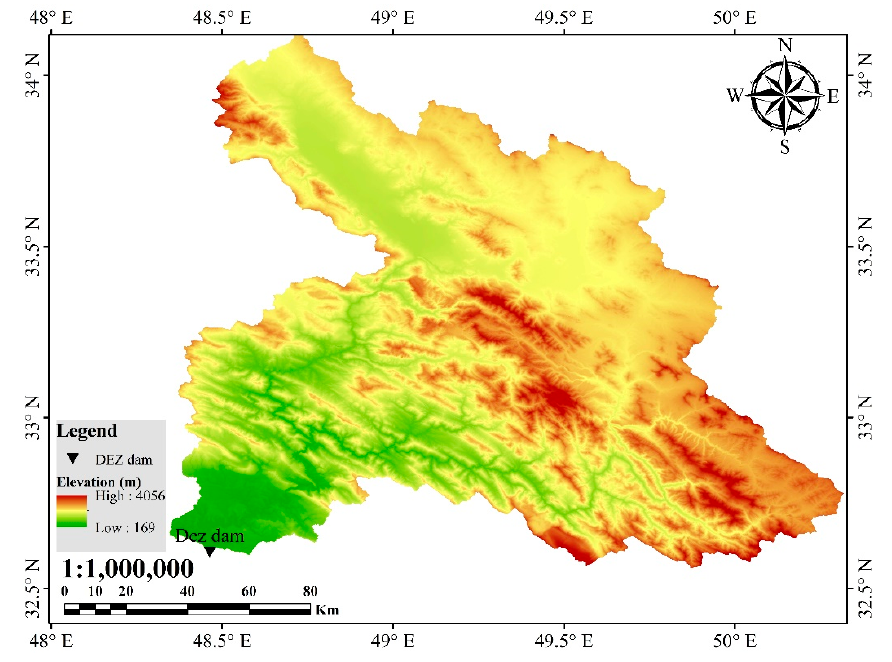
Figure 4. Schematic of Dez basin. Table 2. Dez reservoir